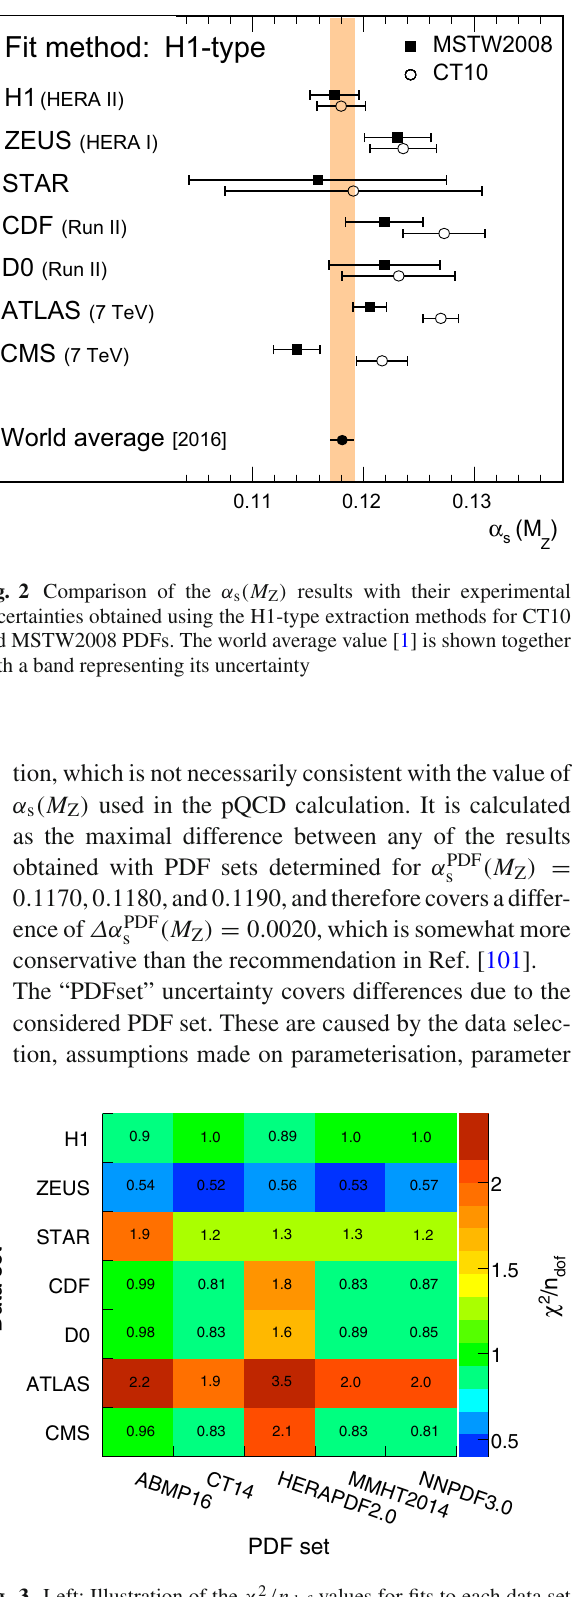
excluded data set is indicated on the y axis and the PDF set on the x axis. The fits are performed for each PDF set in the envelope definition of the PDFset